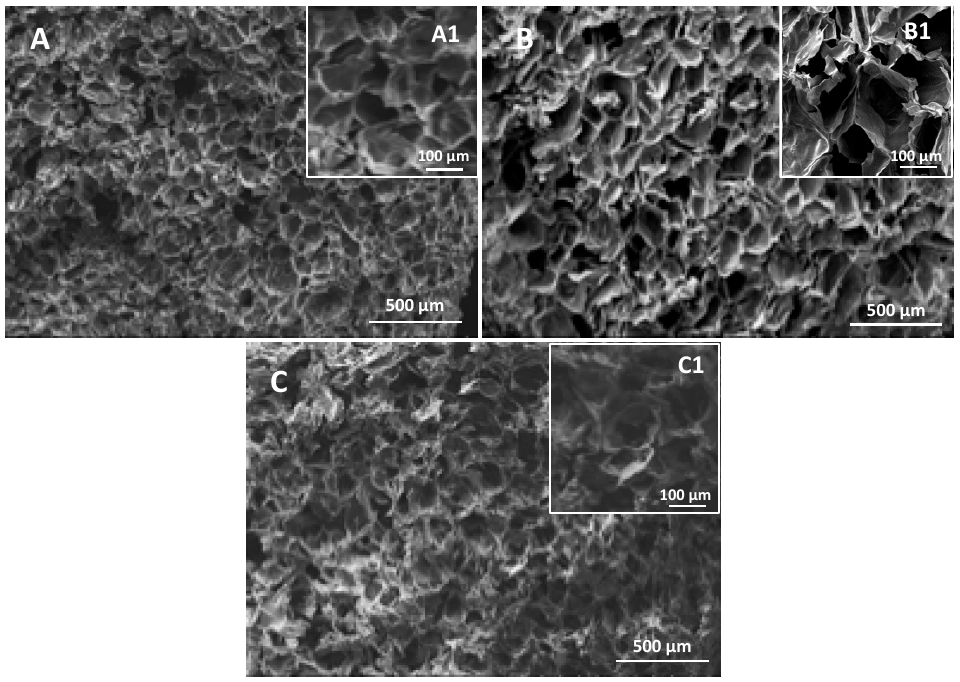
Figure 3. SEM micrographs of cross-sections of freeze-dried hydrogels CHT:PCDi:PCDs: ( A , A1 ) 3:0:3, ( B , B1 ) 3:1.5:1.5 and ( C , C1 ) 3:3:0. Images (A–C) are taken at ×50 magnification and ( A1 – C1 ) are taken at ×100 magnification.